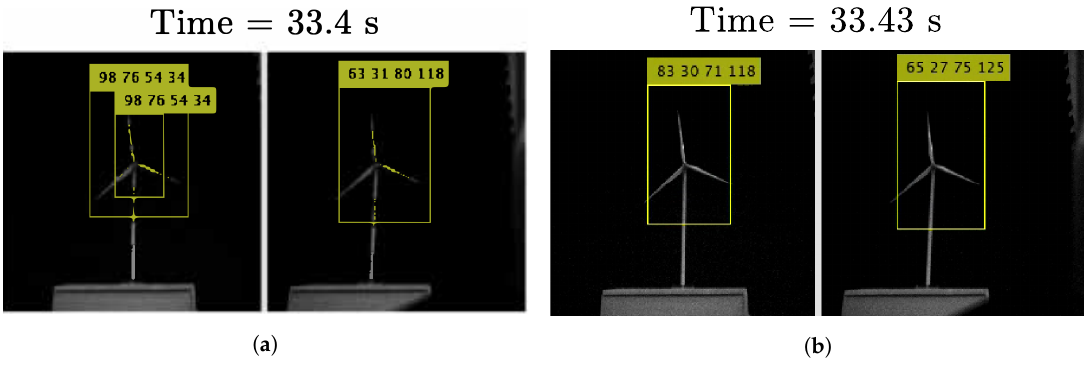
Figure 5. Experiment with the drone stationary positioned 750 mm in front of the wind turbine. ( a ) Image from left and right camera, frame 1; ( b ) Image from left and right camera, frame